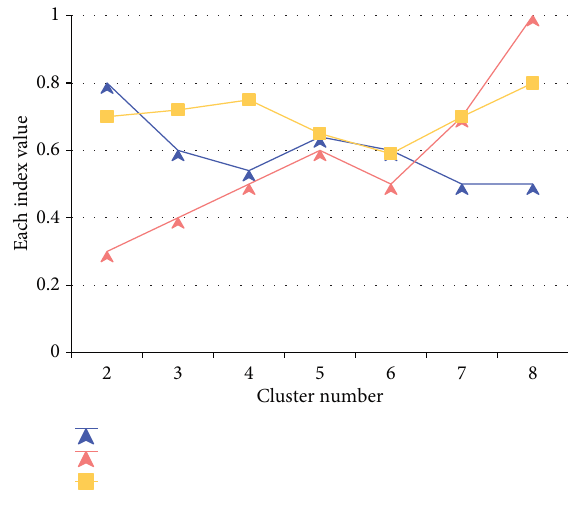
Figure 10: Experimental results of dataset 4.